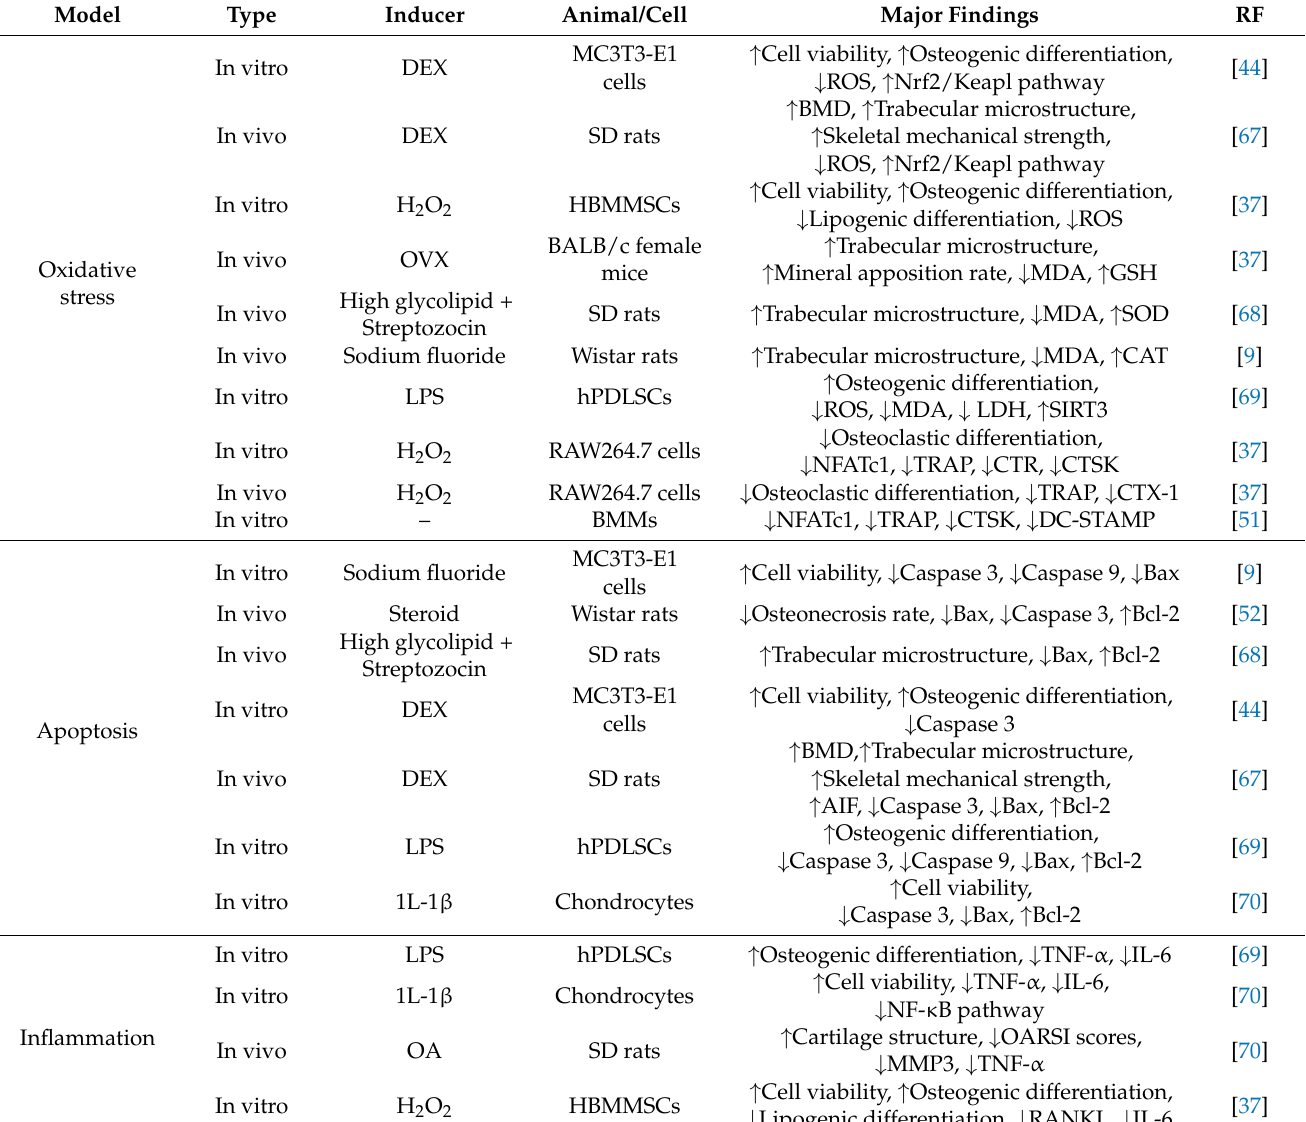
Table 1. Summarized effects of gastrodin on bone metabolism in in vivo and in vitro